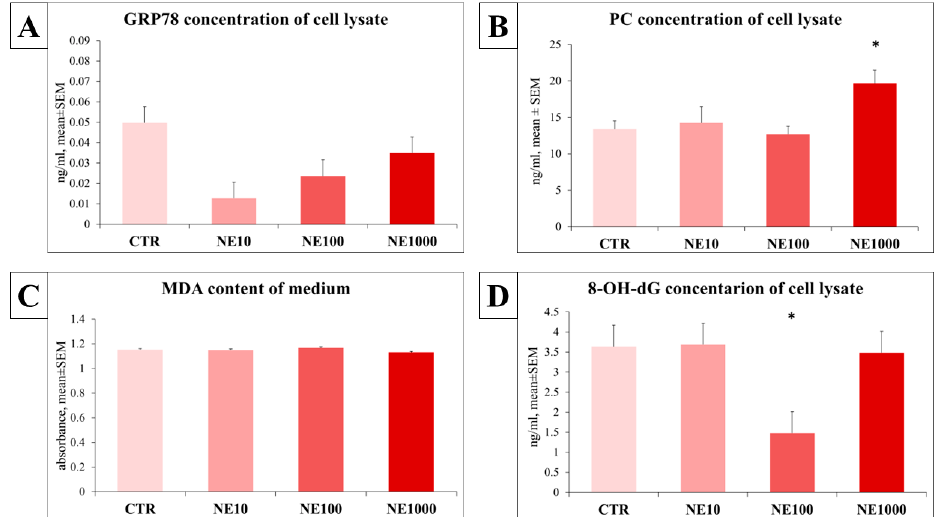
Figure 9. Concentration of oxidative stress markers after 1-h norepinephrine (NE) treatment. Glucose-regulated protein 78 (GRP78) ( A ) and protein carbonyl (PC) ( B ) concentrations in cell lysate, malondialdehyde (MDA) concentration of cell culture media ( C ), and 8-hydroxy 2 deoxyguanosine (8-OHdG) level of cell lysate ( D ). CTR = non-treated control cells, NE10 = 10 µM norepinephrine treated cells, NE100 = 100 µM norepinephrine treated cells, NE1000 = 1000 µM norepinephrine treated cells. n = 6/group, results are expressed as mean ± SEM, * p < 0.05 .